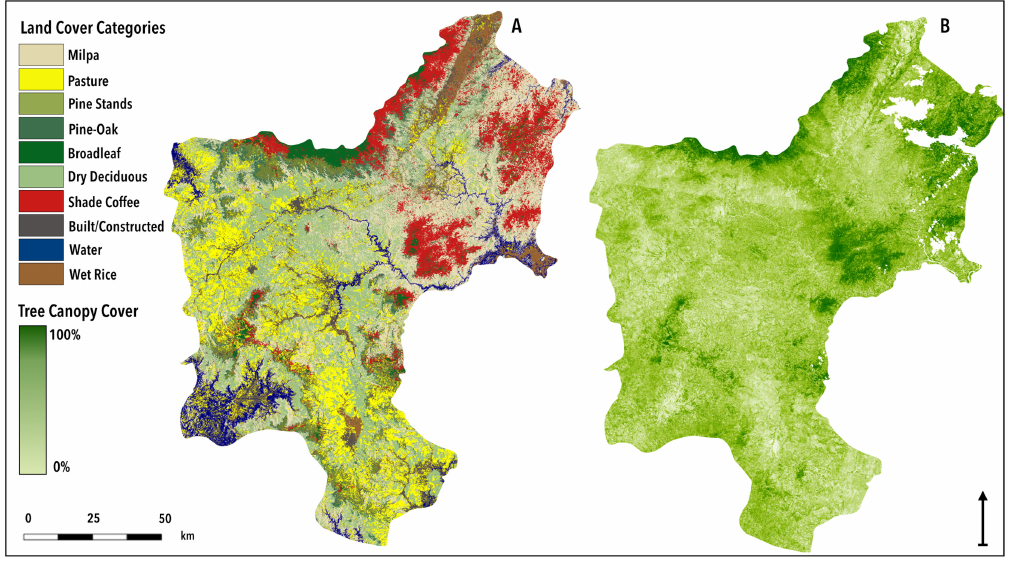
Figure 4. Land-cover classifications as compared to data on tree canopy coverage. ( A ) Land cover classification produced by the full multi-seasonal and topographical data model ( S+TP , mtry = 3, N = 500) with shade coffee depicted in bright red. ( B ) Estimated tree canopy coverage for the reference year 2010, available at 30-m resolution [77]. Coordinates from west to east: − 86.8 ◦ to − 85.8 ◦ . Coordinates from south to north: 12.8 ◦ to 14.1 ◦ Table 4. Confusion Matrix of Best Classification Achieved for the 16-Band Full